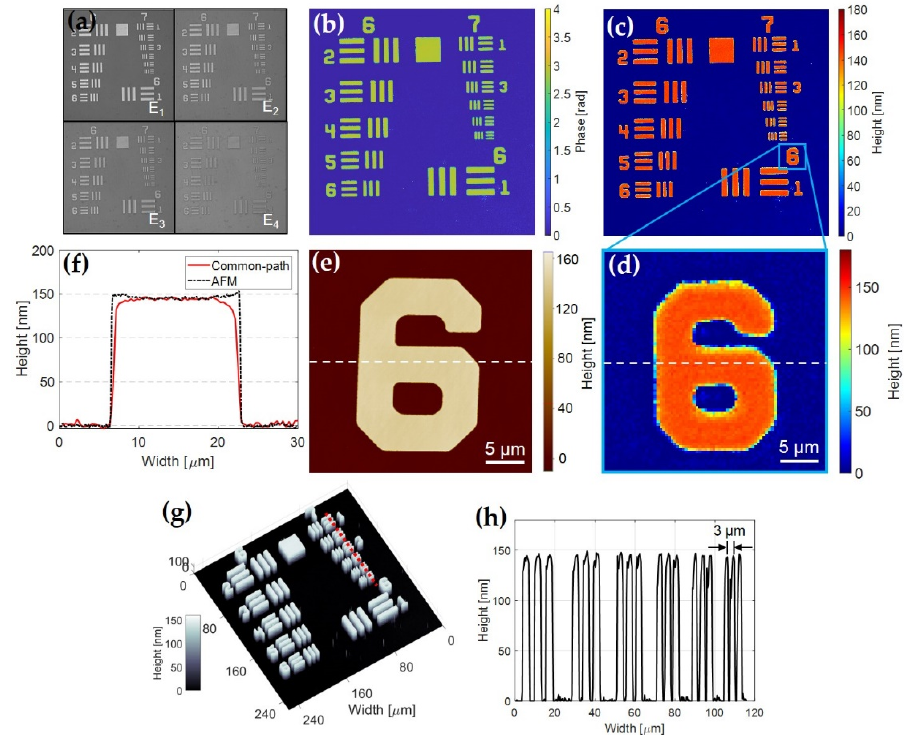
Figure 3. Surface-mapping performance of the proposed method. ( a ) Phase-shifted interference im- ages of a positive 1951 resolution test target immersed in water and exposed to external noise during PSI. ( b ) An unwrapped phase map of the test target, including the physical height of the nanoscopic pattern on the target. ( c ) The height map reconstructed from ( b ). ( d ) A magnification of the height map of the boxed area in ( c ), and the same region scanned with AFM ( e ). ( f ) Height profiles taken along the dotted line in ( e , d ), respectively. ( g ) A 3-D view of ( c ). ( h ) A 1-D height profile taken along the dotted line in ( g ). 3.3. CMP Pad Surface Measurements Using System Furthermore, we tested the surface-mapping performance of our system using a per- forated anodized aluminum plate with a surface structure similar to that of the pad sur- face. The surface-mapping results are shown in Figure 4a–d. Figure 4a is a microscope image (300 × 300 μ m) of the aluminum plate used in our set-up, showing the microporous surface. Figure 4c is a phase-shift contrast image obtained after a series of post-processing steps using the phase-shifted interference images (Figure 4b), where the darker areas rep- resent deeper valleys in the surface profile. A topology of the mean-referenced surface map is displayed in pseudo color in Figure 4d, delineating the microscopic pores (arrow heads) and asperities (asterisks) on the surface, which correspond to the symbols in posi- tions in Figure 4a. Finally, CMP-pad imaging was performed using the system. A fully processed (worn out) commercial pad was prepared for imaging; its strip was immersed in diluted water to simulate the use of the polishing pad in a turbid medium, i.e., a slurry mixture. The vibration and tapping on the optical table were repeated to mimic the typical industrial environment. Figure 4e shows a microscope image of the surface of the pad strip in the emulsion. The bright spots (indicated by arrows) in the image result from significant re- flectance caused by air bubbles in the pad pores. These air bubbles were removed using a micropipette prior to experiment. Without this step, the highly reflective liquid–air inter- face may have prevented the generation of interference at the pores, resulting in an error in the measurement of the pad asperity. It has been carefully speculated that the cause of bubble formation in the pores may be air that is accidentally trapped in the immersed